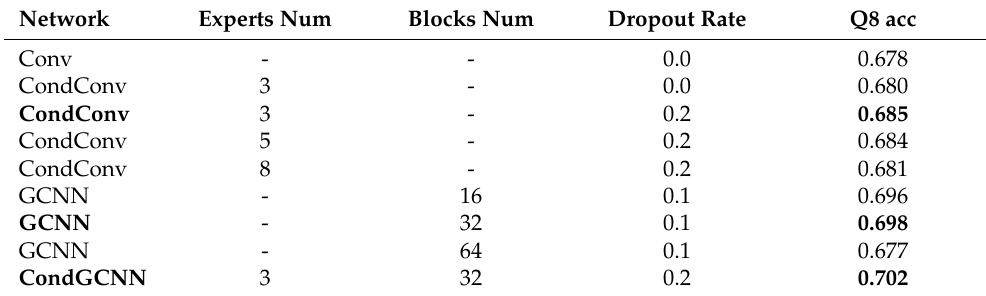
Table 2. Q8 accuracy of CNN, CondConv, GCNN and CondGCNN on cb513 dataset with different structural